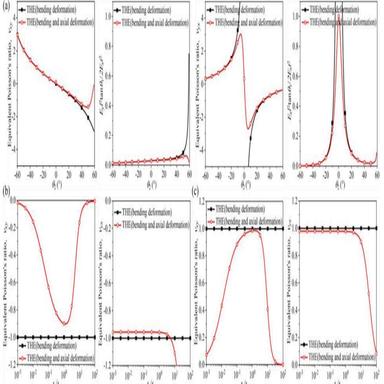
Comparison of theoretical results of 3D DVH lattices with single constitute material when considering bending and axial deformations, (a) equivalent Poisson's ratio and normalized Young's modulus of 3D DVH lattices as functions of θ2 when considering pure bending deformation as well as bending and axial deformations (θ1 = 60◦, t1/l = t2/l = b/l = 0.1), equivalent Poisson's ratio of (b) concave (θ1 = 60◦, θ2 = 30◦) and (c) convex (θ1 = 60◦, θ2 = − 30◦) 3D DVH lattices as functions of relative thickness t1/t2